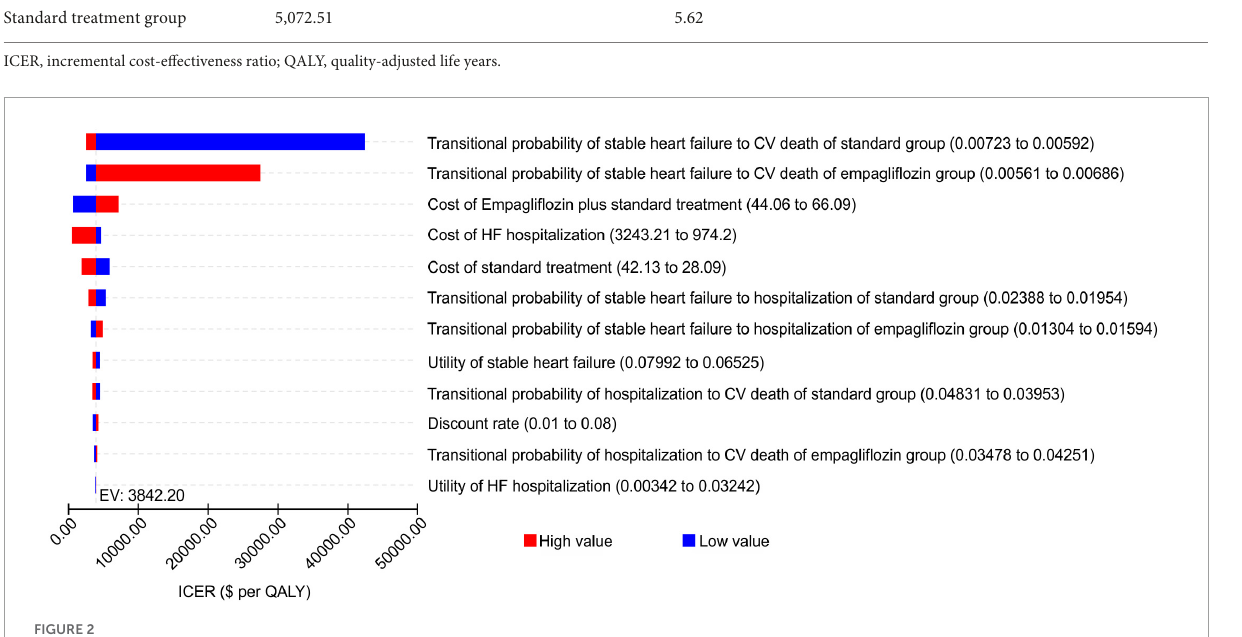
FIGURE2 Tornado diagram showing the univariate sensitivity analysis of the Markov model simulation (empagliflozin group vs. standard